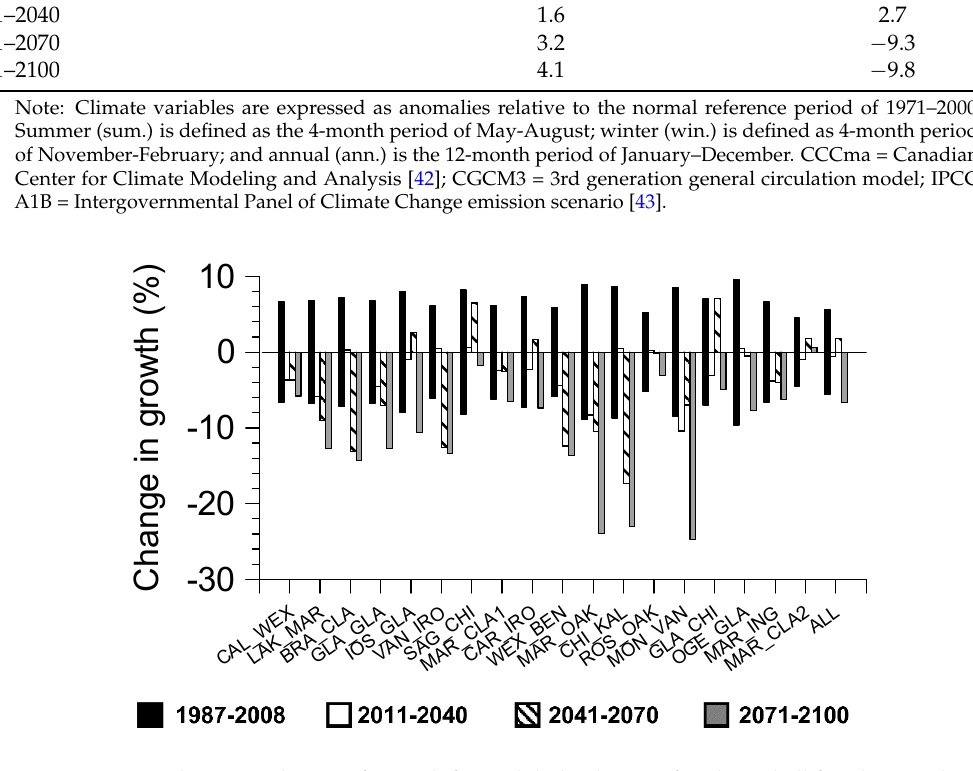
Figure 5. Projected percent change of growth for each hybrid aspen family and all families combined under the IPCC A1B climate change scenario and based on moisture index regression models. A 95% confidence interval of growth for the period of 1987–2008 is also shown.